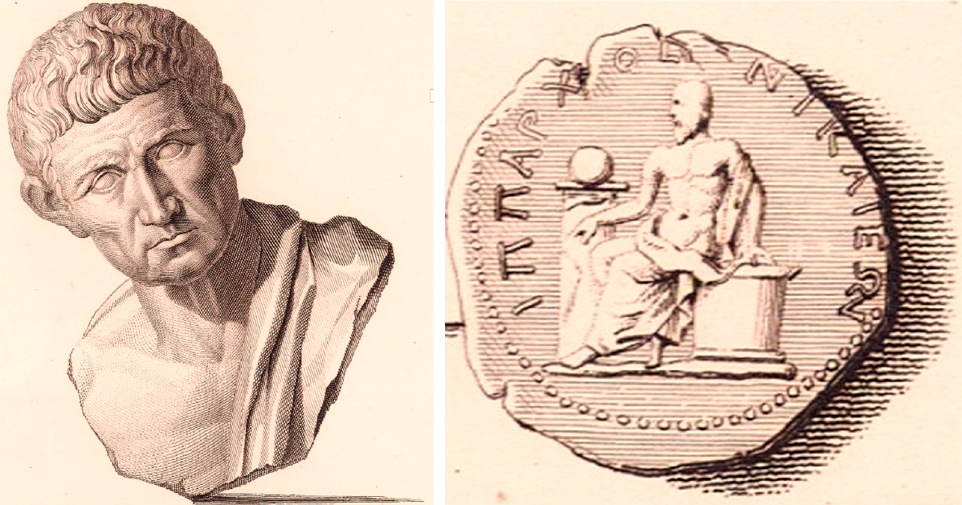
Figure 1. ( left ) Aristotle ( Ἀριστοτέλης ; 384–322 BC), Greek philosopher of the Classical period, founder of the Lyceum and the Peripatetic school of philosophy. ( right ) Hipparchus of Nicaea ( Ἵππαρχος ὁ Νικαεύς ; c. 190–c. 120 BC), Greek astronomer, geographer and mathematician founder of trigonometry and discoverer of the precession of the equinoxes, depicted in the back facet of a coin of the Roman period. (Image sources: [3]).